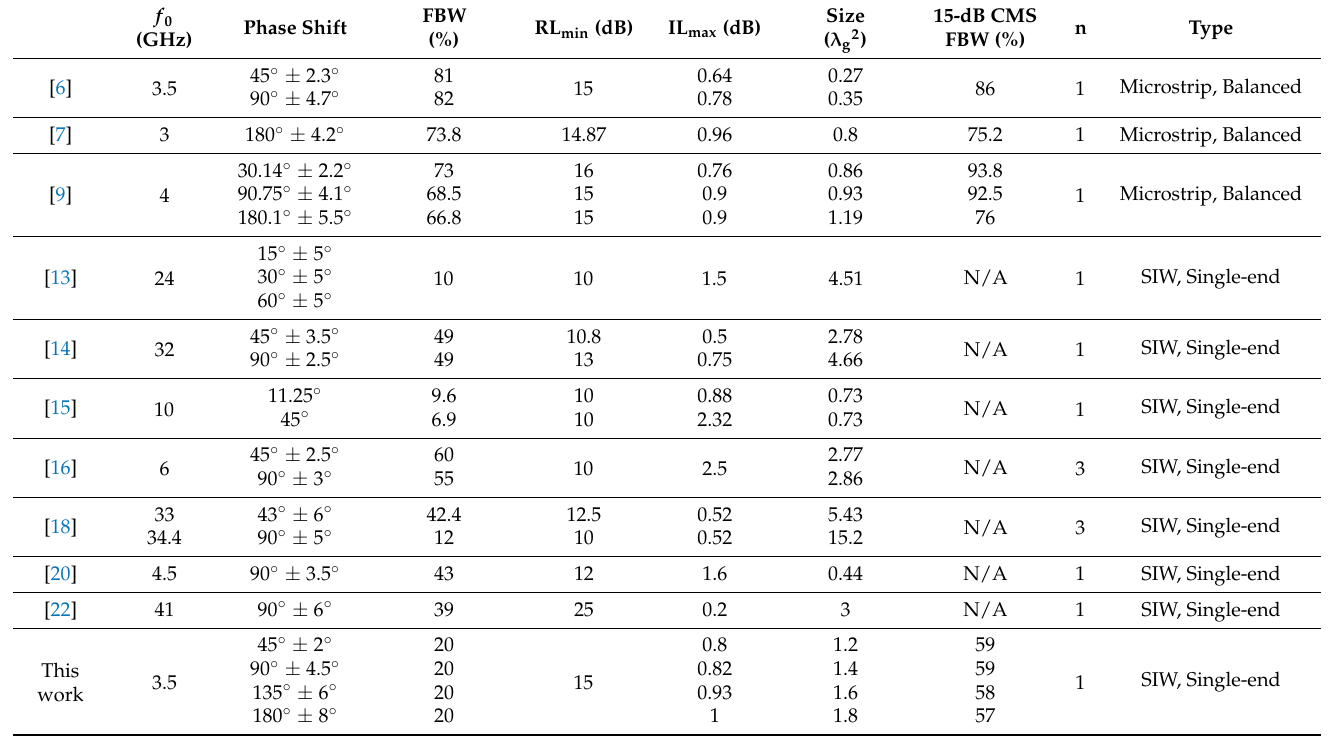
Table 2. Performances comparison with previous